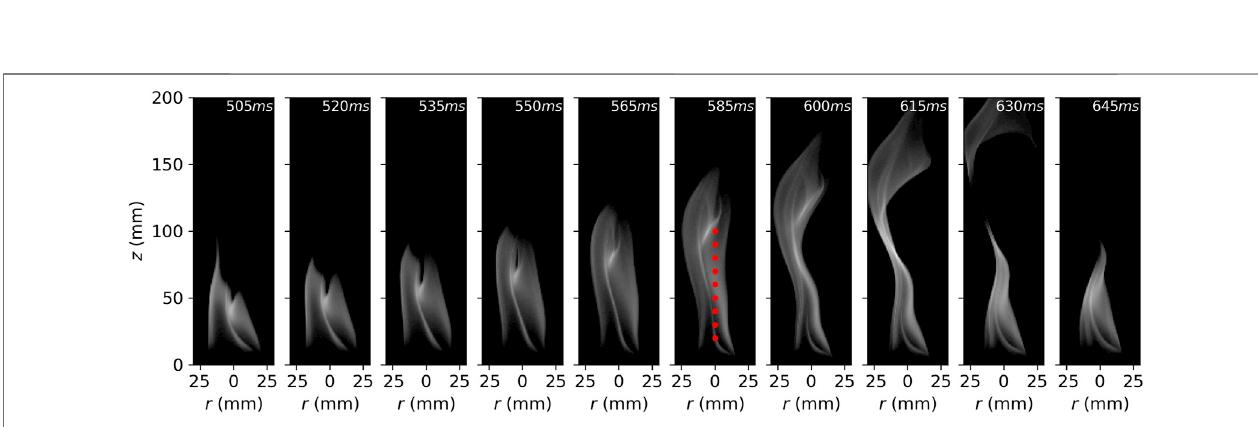
FIGURE 3 | Flame sequence captured at 250 fps. The red dots indicate the nine HABs where the AC-LII measurements were performed.